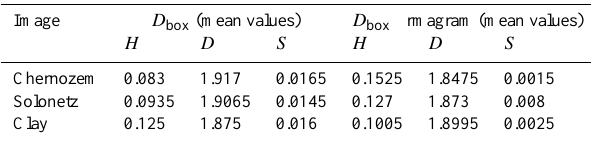
Table 1. Mean Hurst exponents ( H ), fractal dimensions ( D ) and standard deviations ( S ) measured by box counting method for sev- enteen analyzed images of three compared soils and their respective